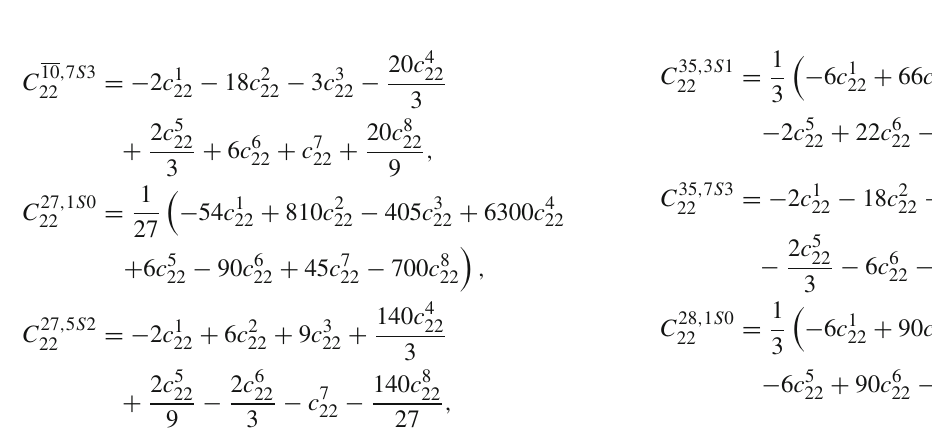
Table 6 SU(3) relations of BB → BB in non-vanishing partial waves. The subscript { 00 } of the constants C r omitted in the